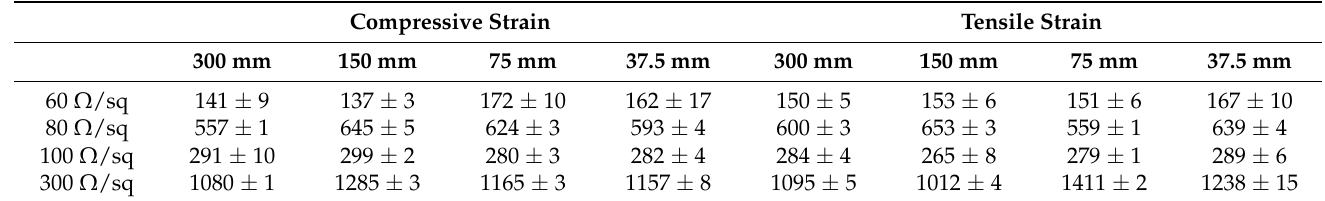
Table 3. Results obtained from the measurement of the surface resistivity ( Ω /sq) of the ITO-PET samples under different radii of curvature. Measurements are expressed as ( Ω /sq) and dispersion as %. Compressive